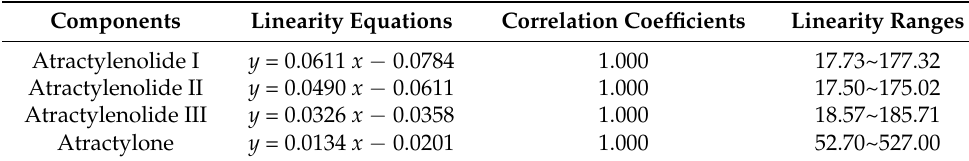
Table 3. Linearity equations, correlation coefficients, and linearity ranges.